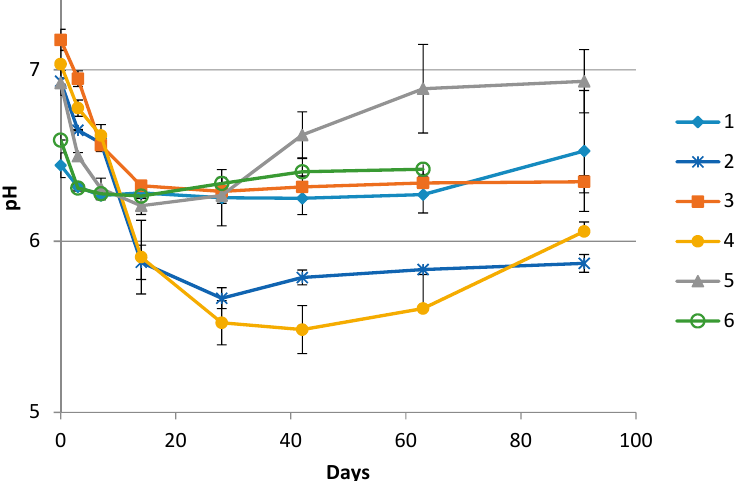
Figure 1. pH values in brine collected from the middle layer in the containers from the individual producers (1–6) during the rakfisk ripening process. (Day 63 was the last sampling day from Producer 3). Error bars represents the standard deviation of the triplicate biological